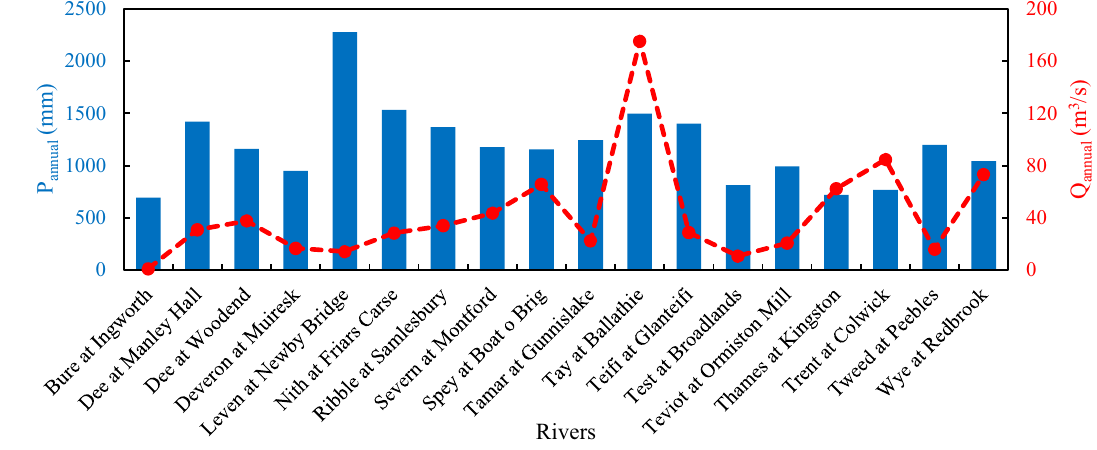
Figure 2. Average annual precipitation and streamflow